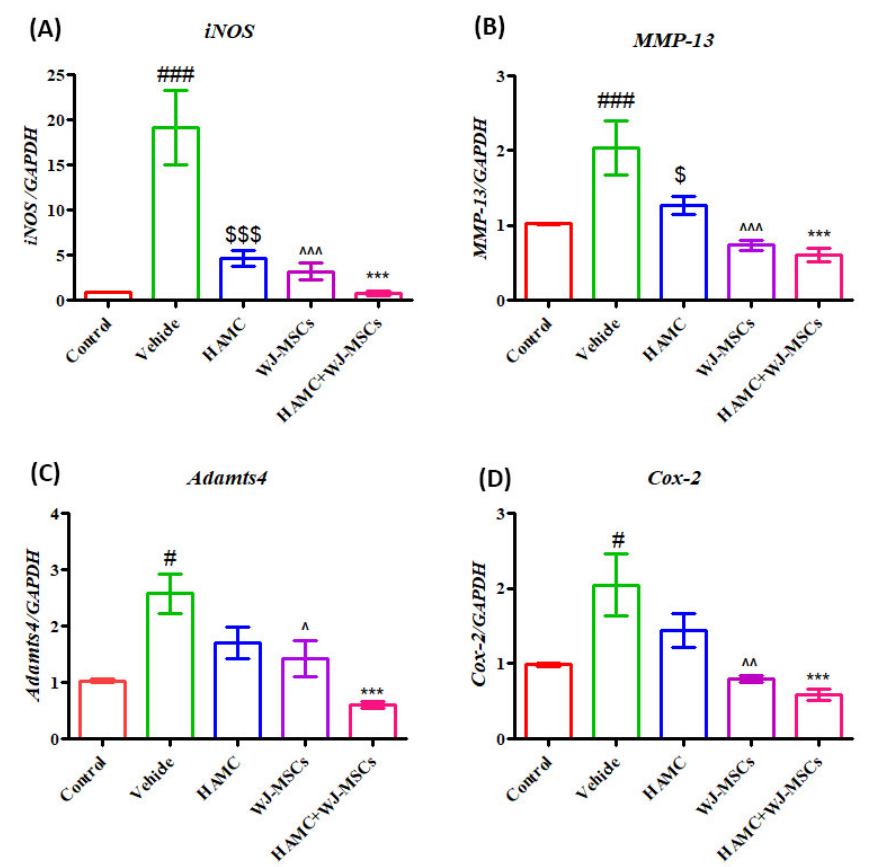
Figure 6. Combined injection of HAMC and WJ-MSC inhibits the mRNA expression of pro-inflammatory cytokine and matrix-degrading enzymes. ( A ) iNOS mRNA expression, ( B ) MMP-13